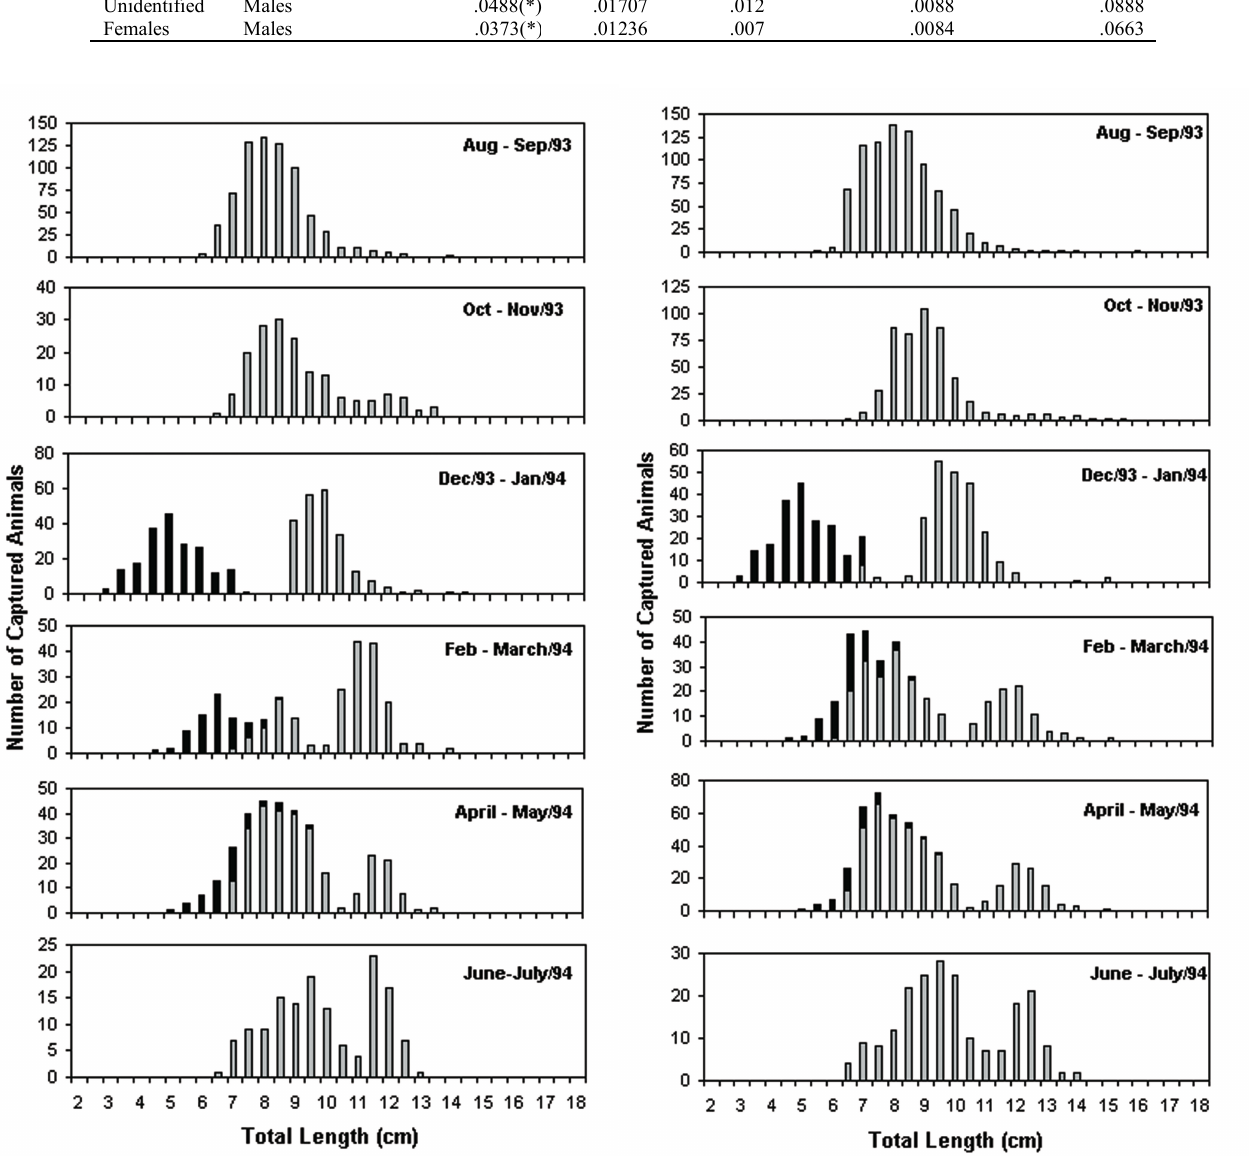
Fig. 3 . Length frequency distributions of females of the silverside Atherinella brasiliensis in Tramandaí Estuary, Southern Brazil. Black bars represent small animals with no gender identification and equally distributed as males or females.